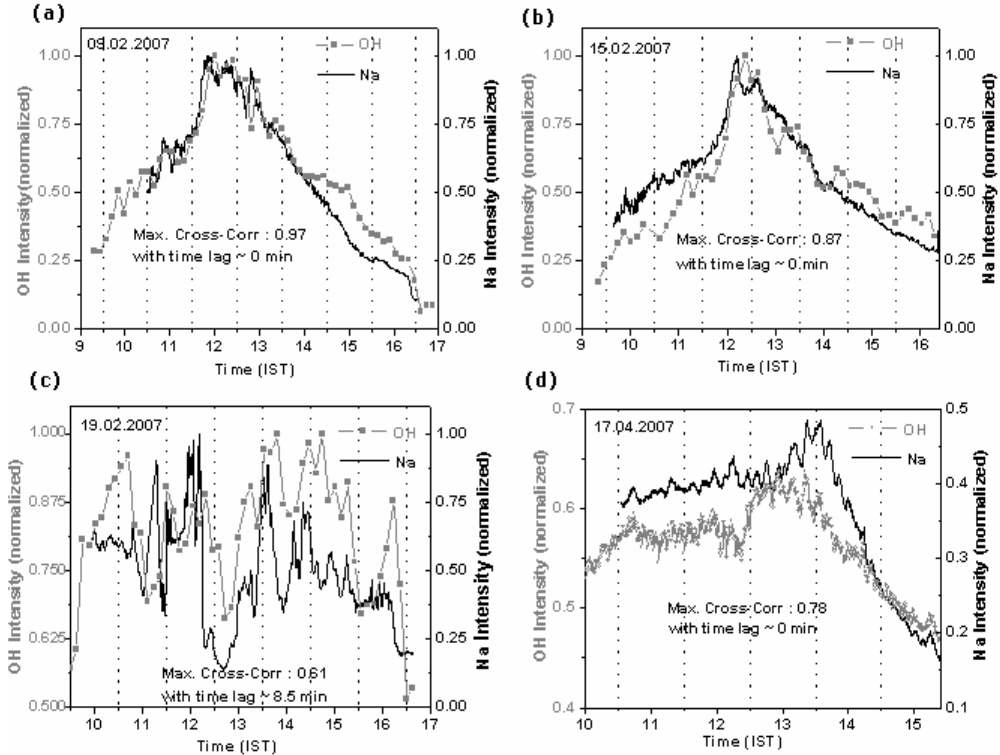
Fig. 3. (a–d) Comparative plot of the temporal variabilities of the Na and OH emissions on 4 days during February